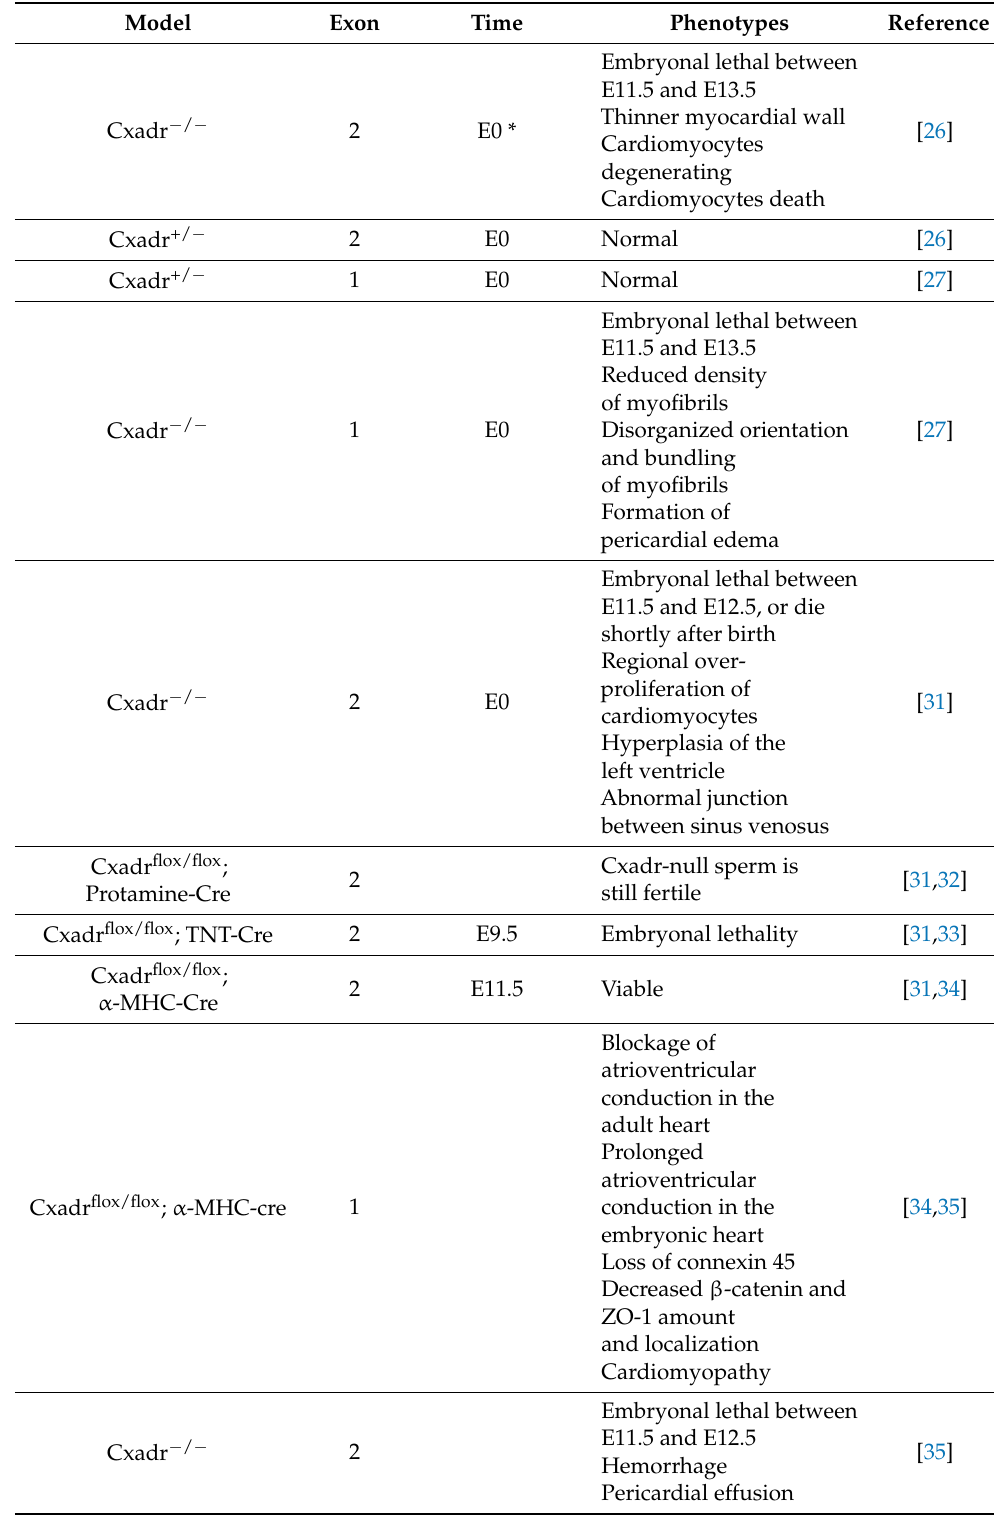
Table 1. Phenotypes of current generated CXADR knockout mouse